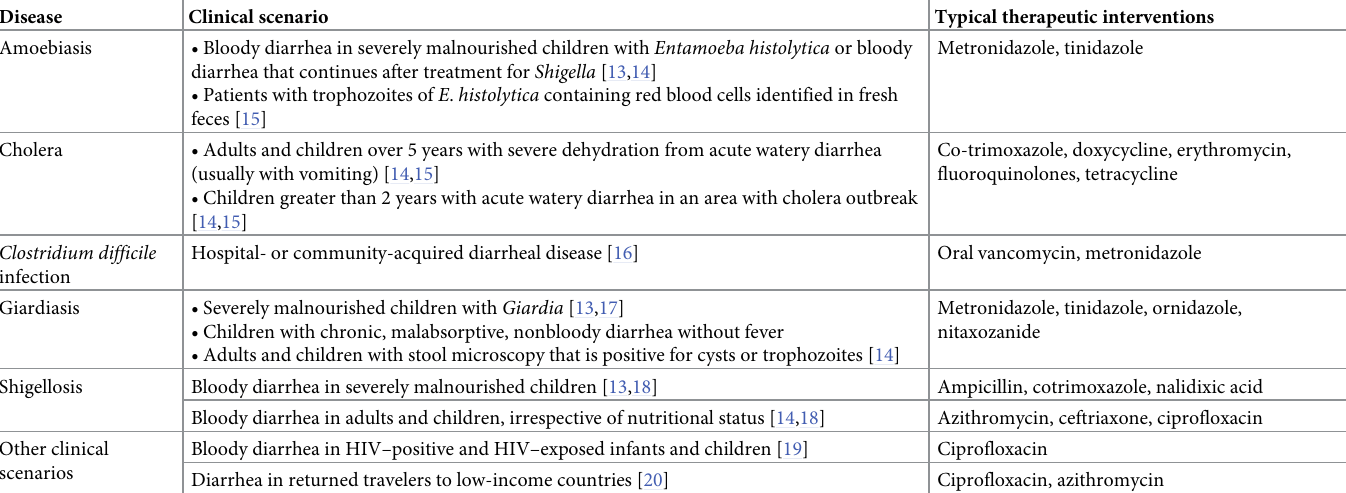
Table 1. Clinical scenarios where pathogen- or syndrome-specific treatment is applied for diarrheal disease. This table summarizes relevant aspects of treatment guidelines published by the World Health Organization and other groups. It is acknowledged that the evidence base for some interventions is variable and the use of these therapies in practice is often country- and